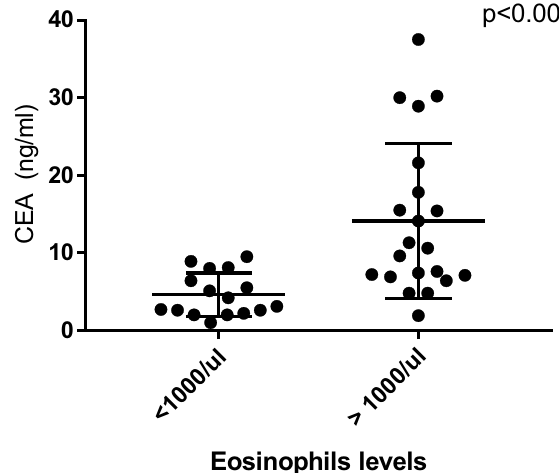
Figure 6. A higher eosinophil count is with the echo of higher levels of CEA.